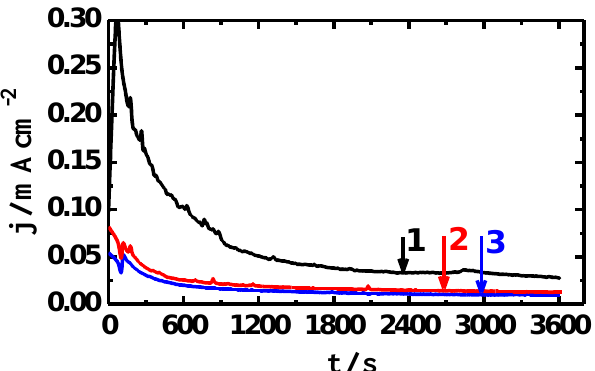
Figure 8. Chronoamperometric curves obtained for (1) hot swaged, (2) annealed at 800 °C; and (3) annealed at 940 °C Ti-45M electrodes after their immersions in 2 M HCl for 1 h, respectively, followed by stepping the potential to +1.4 V vs. Ag/AgCl for 1.0 h.